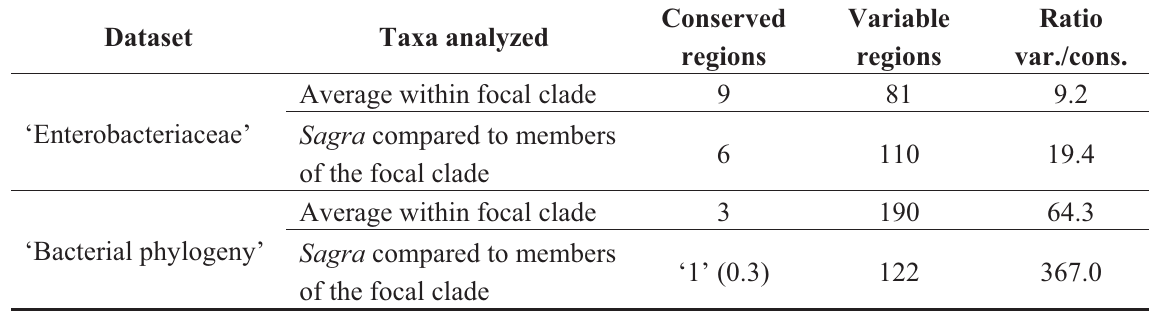
Table 5. Number of nucleotide substitutions in conserved vs. variable regions in sequences of Sagra symbionts and members of the focal clade, and the ratio (variable/conserved) (further explanations: see Table